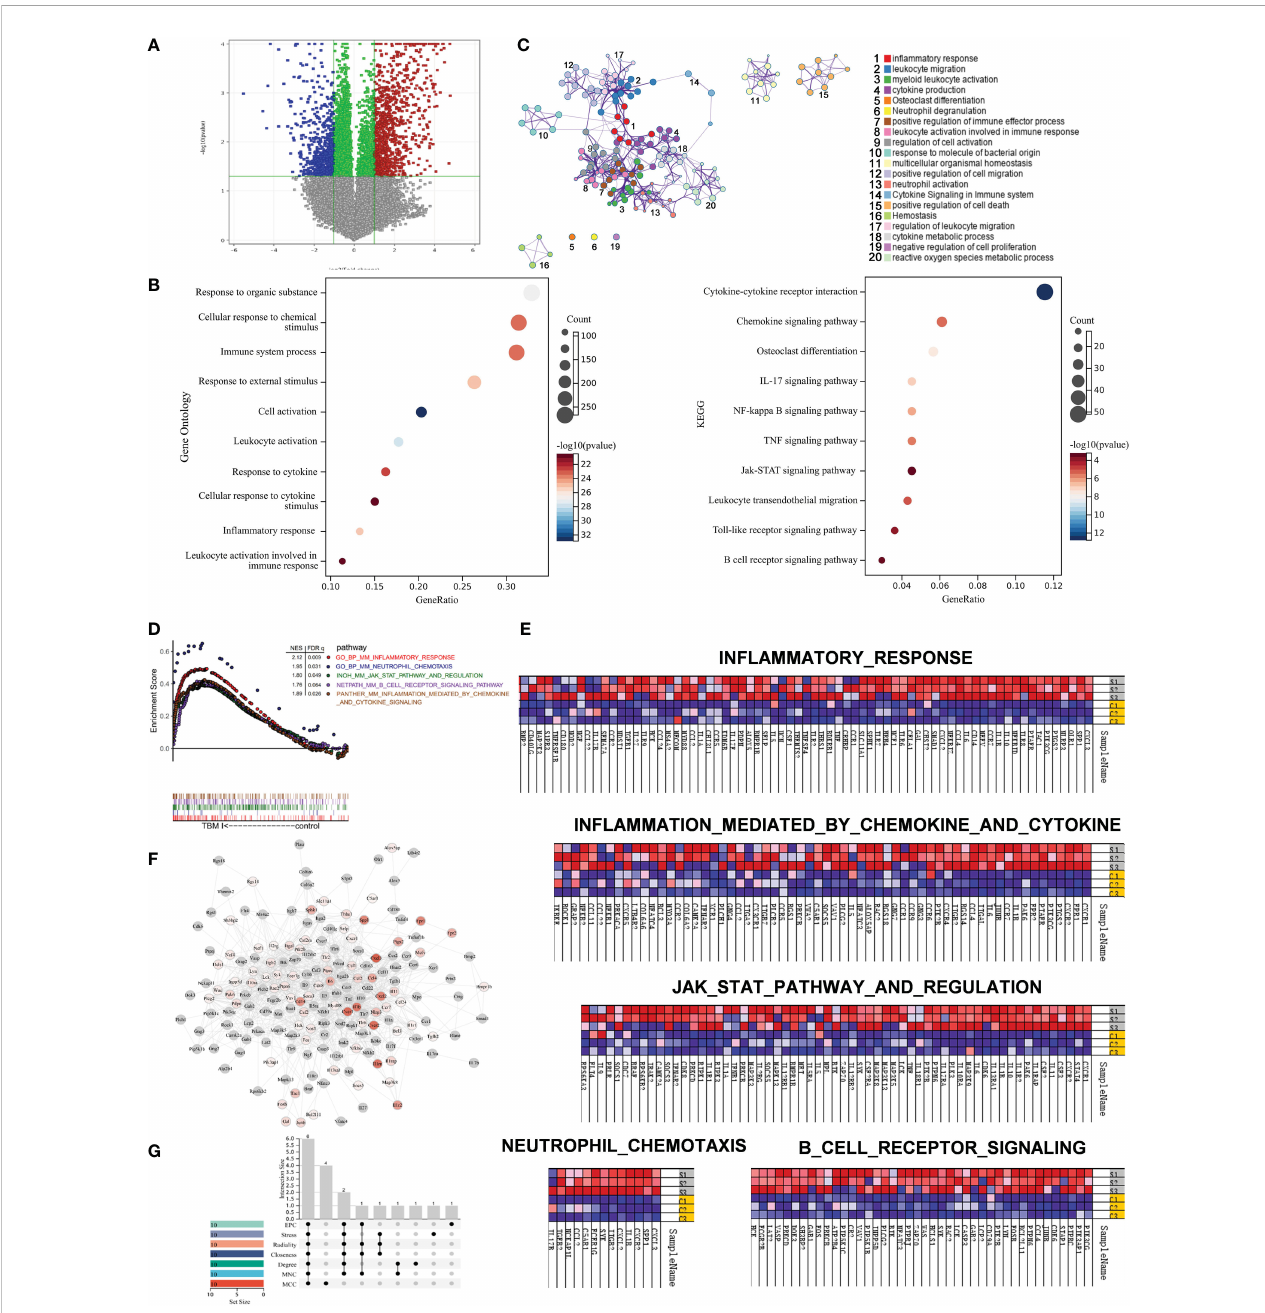
FIGURE 7 Gene set enrichment analysis of gene expression pro fi les in mouse quadricep muscles induced by TBM I and hub genes screening. (A) Volcano plots of gene expression in quadricep muscles. (B) GO function and KEGG pathway of DEGs. (C) Network of GO biological processes of DEGs. (D) Five leading-edge gene sets using GSEA. (E) Heatmap of enriched genes for each gene set. S1, S2, and S3 represent three replicates treated with TBM I C1, C2, and C3 represent three replicates of PBS control. (F) PPI network of core genes from GSEA. (G) The Upset plot of 6 overlapping hub genes by seven